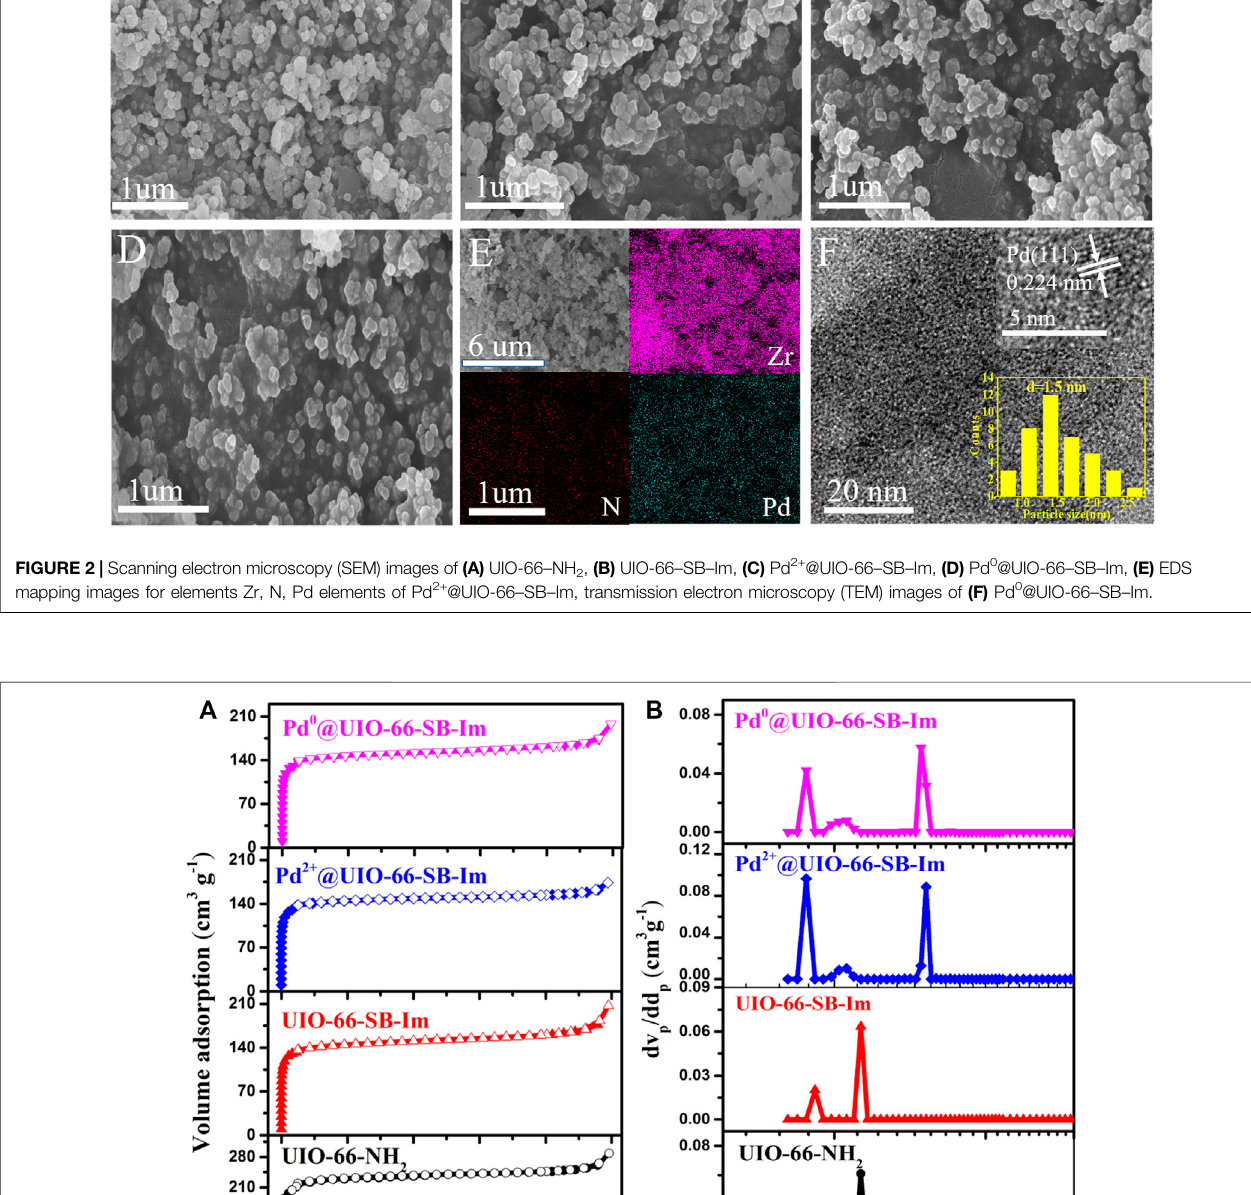
Frontiers in Chemistry |